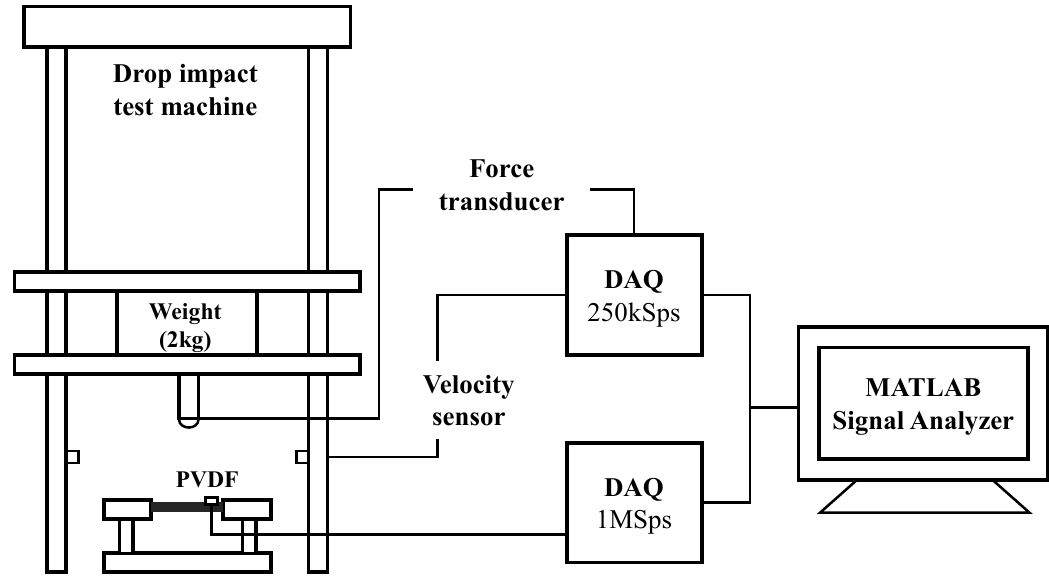
Figure 4. Experimental setup for acquiring PVDF signals and impact response data from drop impact tests.